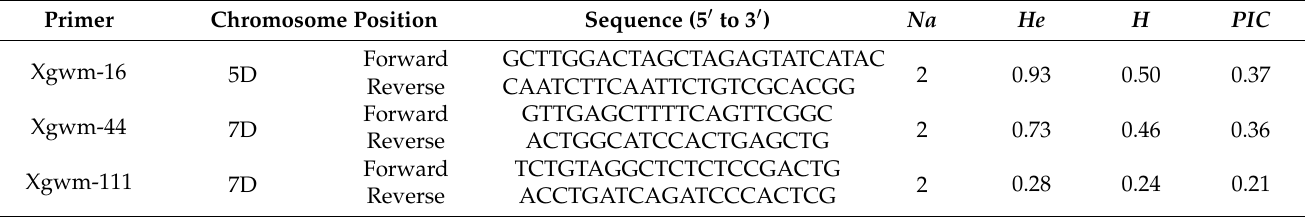
Table 1. Estimated informativeness parameters for the utilized SSR markers in the present